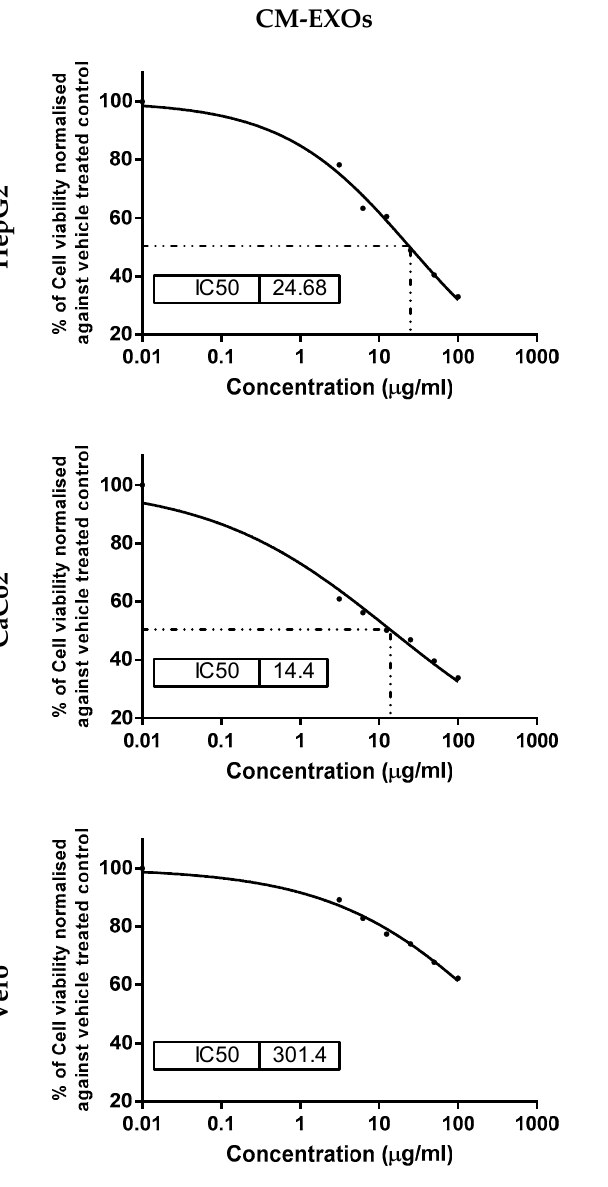
Figure 4. The sigmoidal curves for the effect of CM-EXOs and cisplatin on HepG2, CaCo2, and Vero cells show the IC 50 . Each data point represents an average of three independent experiments ( n = 3).